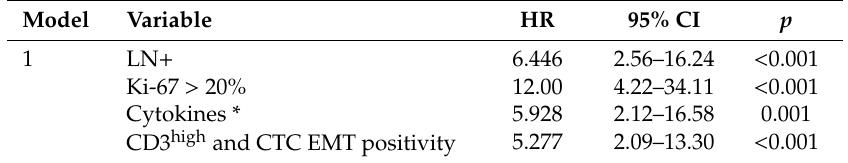
Table 2. Cox proportional hazard regression models for the association between clinical predictor variables, plasma cytokines, the interaction between individual TILs and CTC EMT, and